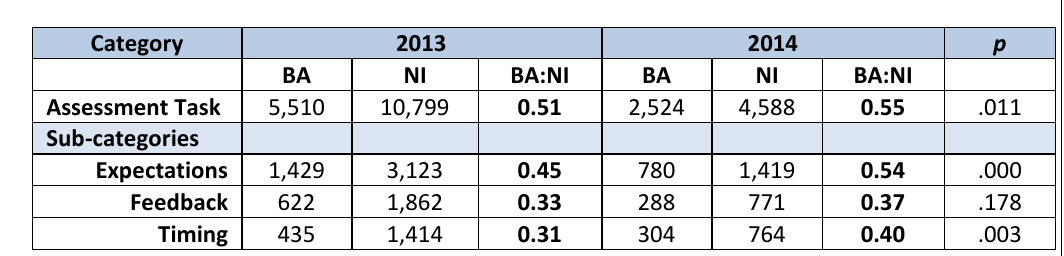
Table 3: Ratio of BA to NI comments for SFU assessment